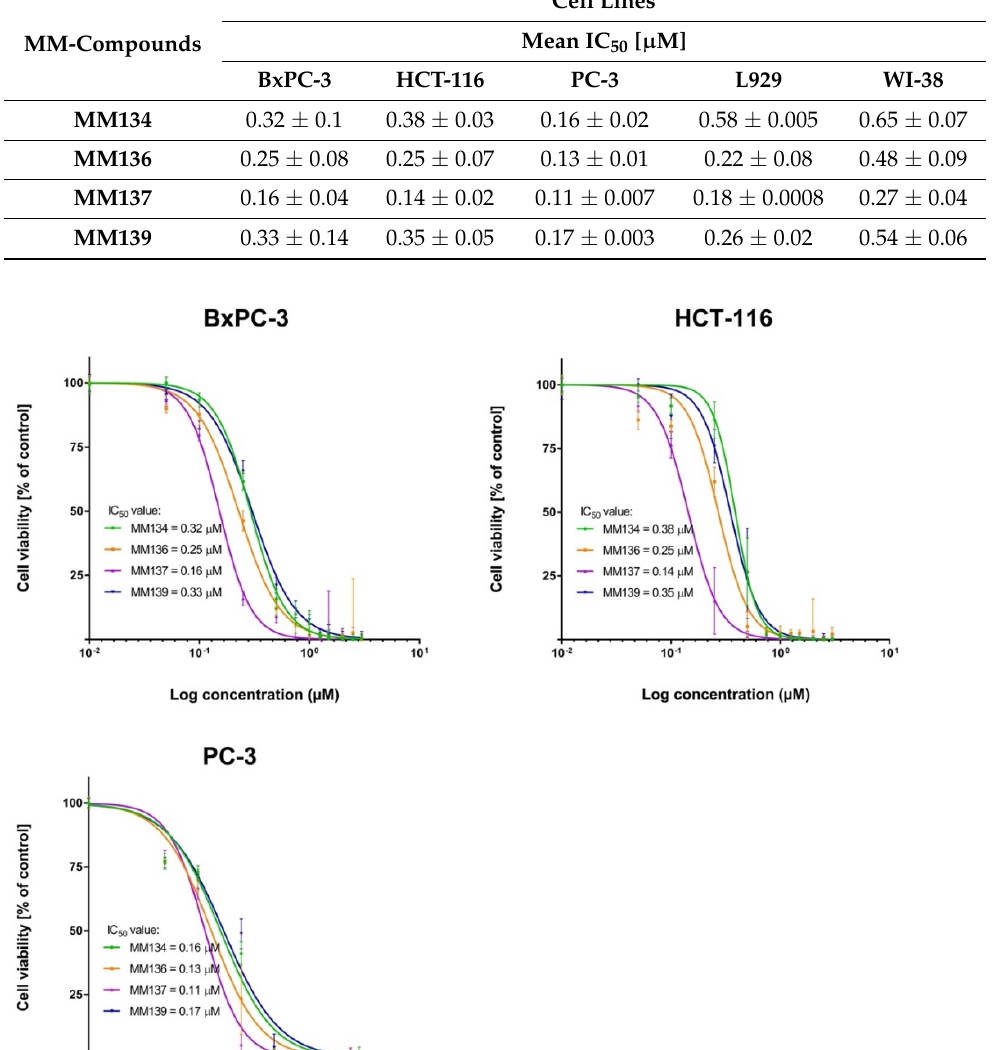
Table 1. Mean IC 50 obtained after a 72 h incubation of tested cells with MM-compounds in MTT assay ± SD. Cell Lines Mean IC 50 [ µ M] MM-Compounds BxPC-3 HCT-116 PC-3 WI-38